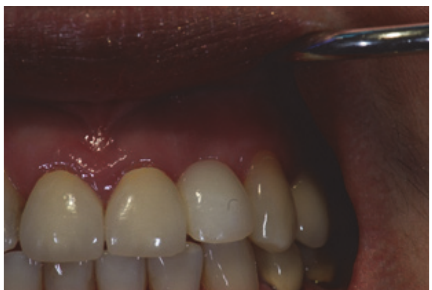
Figure 12: Final restoration of the implant in the #10 region.